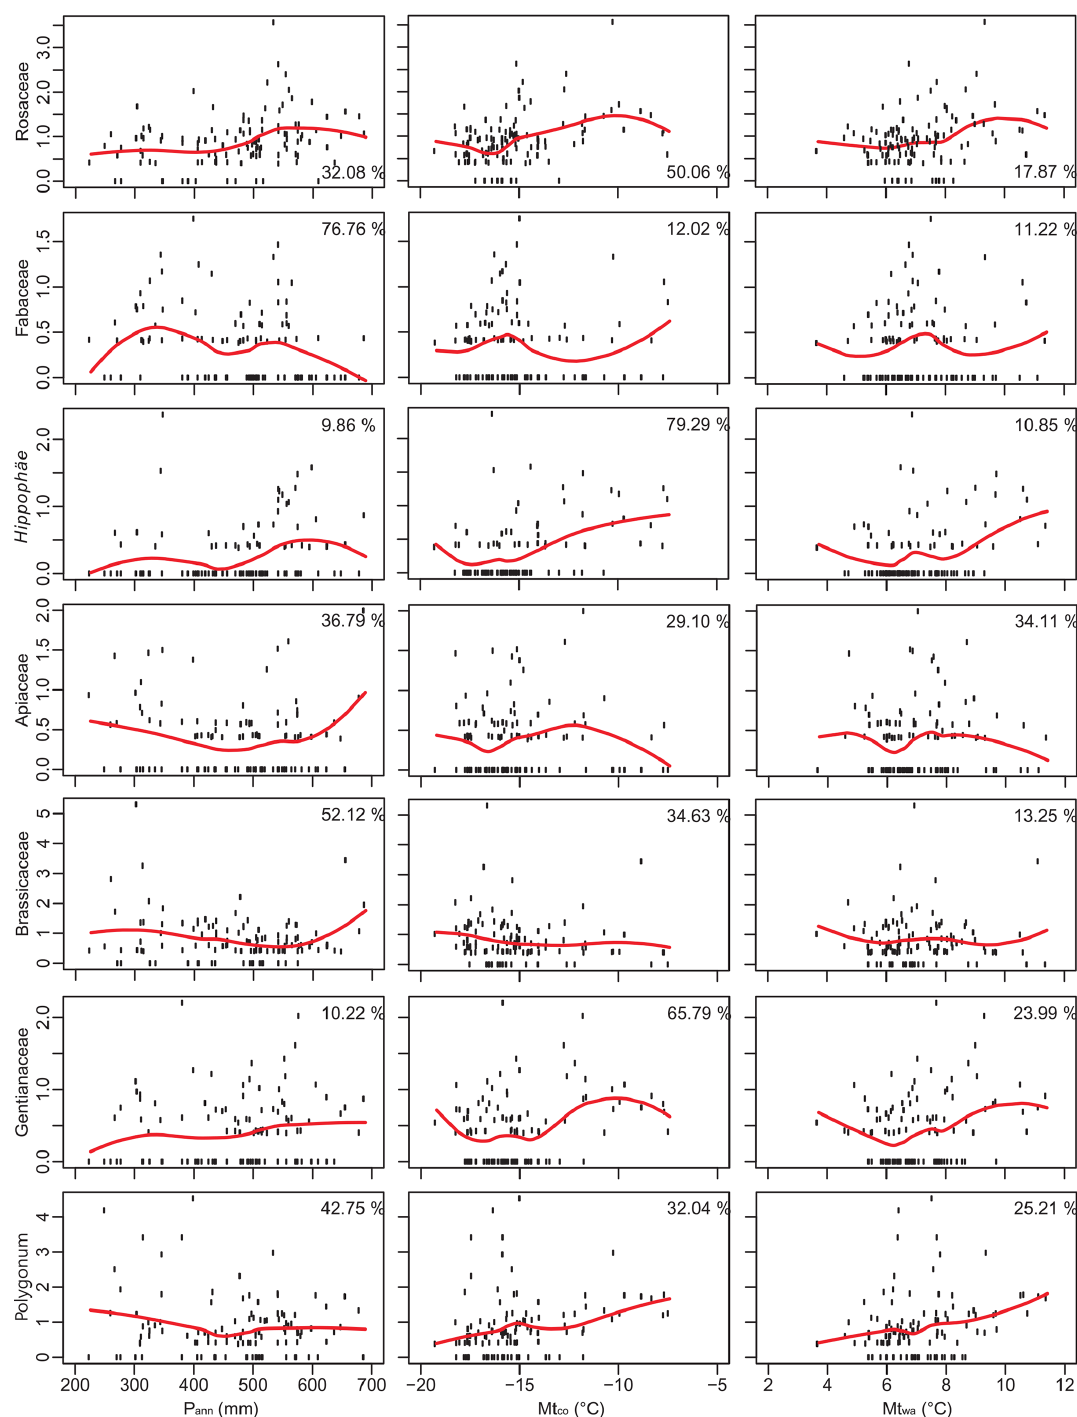
Figure A1. BRT-modelled climate influences on pollen (seven common or minor taxa) percentages. The pollen responses to three climatic variables (red curves) are fitted with a local polynomial regression